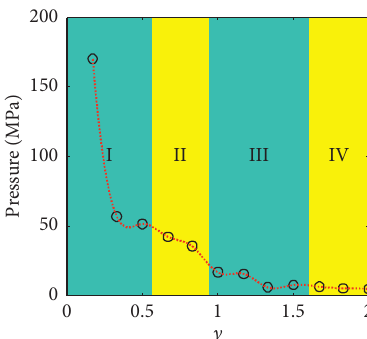
Figure 25: Pressure peak of wall pressure variation diagram in the first cycle for 0.17 ≤ c ≤ 2.00.